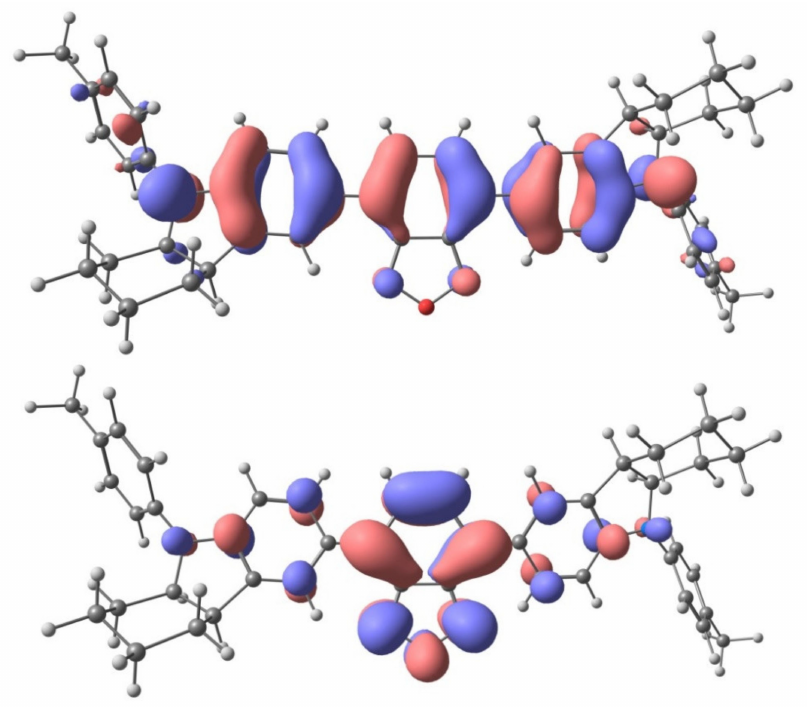
Figure 6. The calculated HOMO ( top ) and LUMO ( bottom ) orbitals for 1a compound on the geometry of S 1